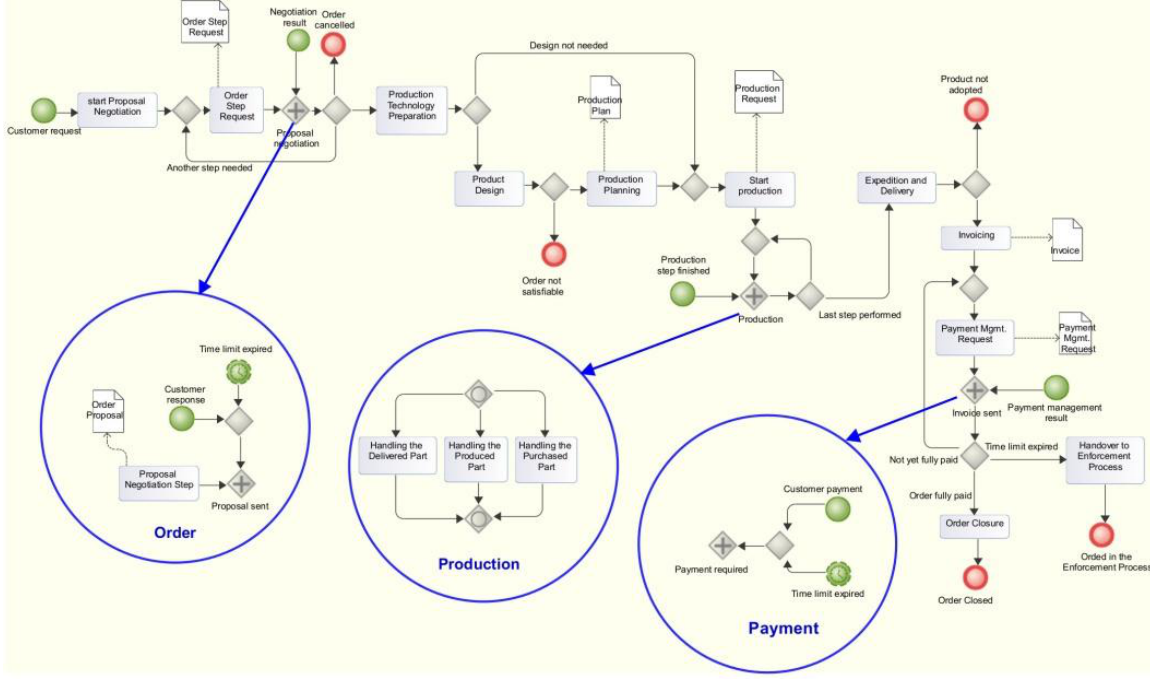
Figure 3 . Example – Process in the 1st Normal